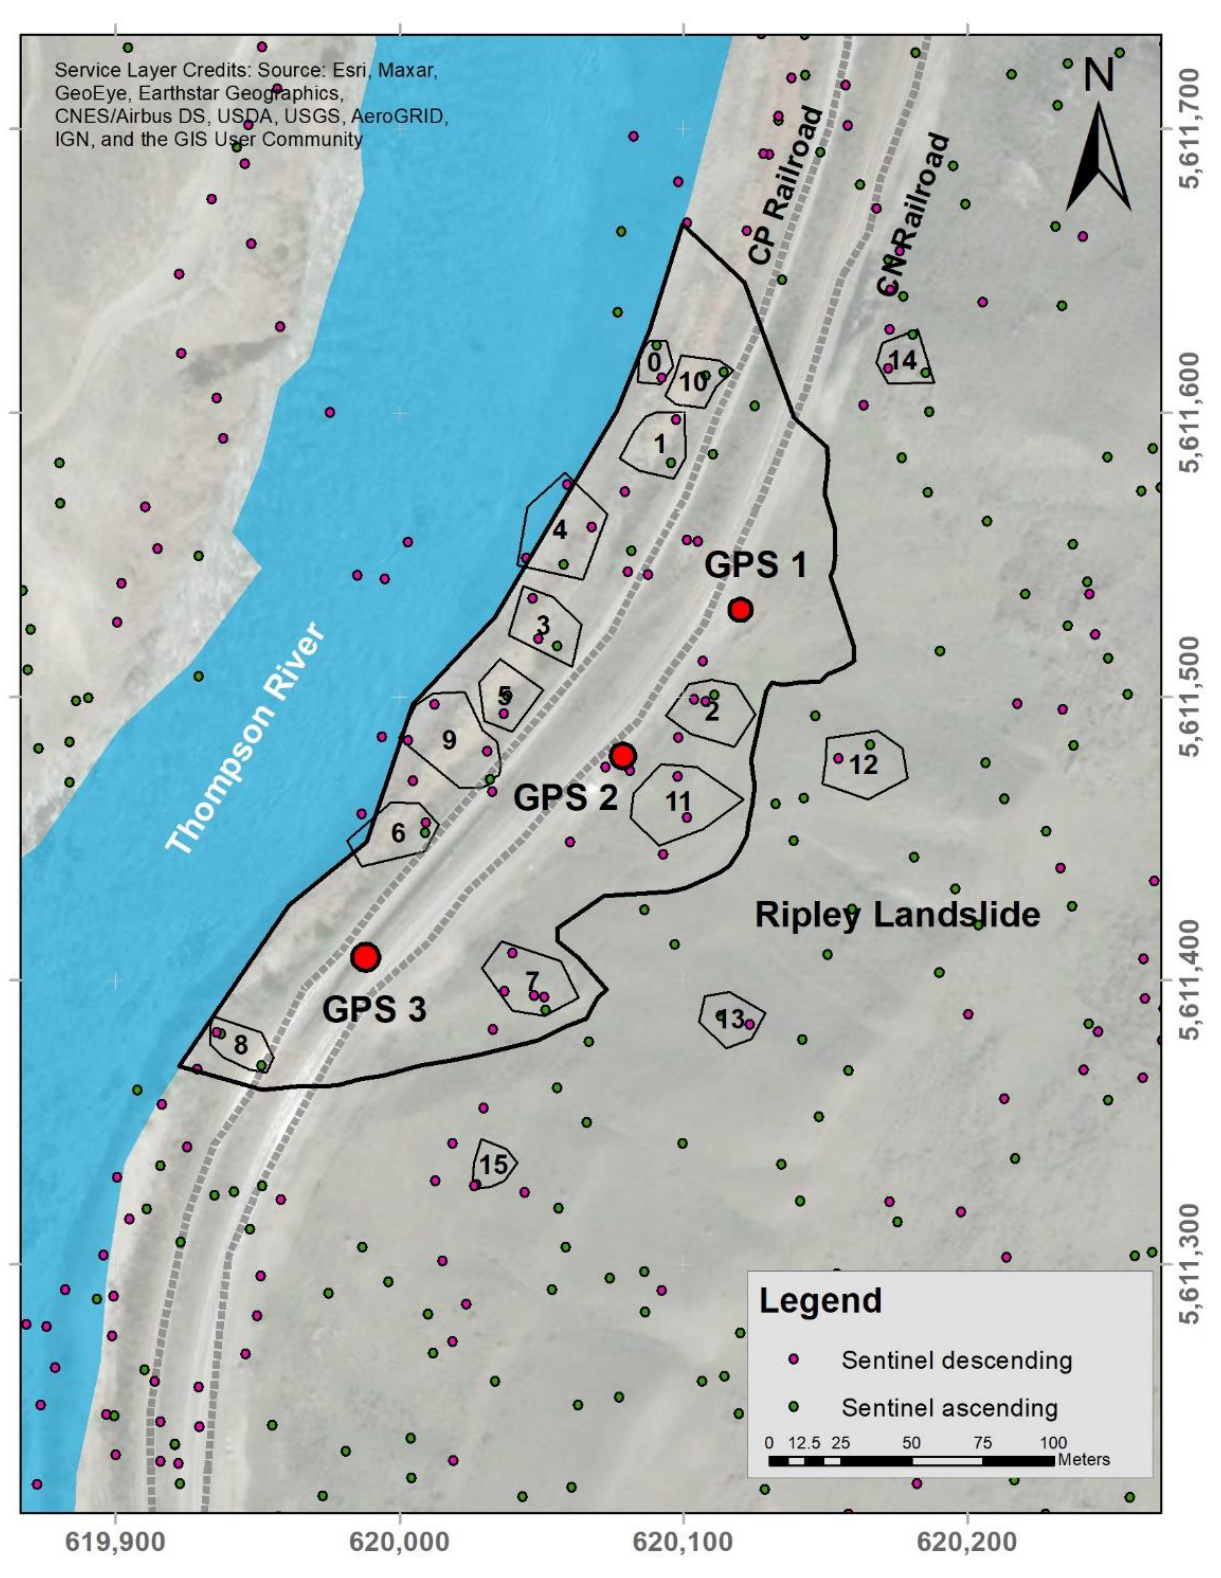
Figure 3. Location of installed GPS systems on Ripley landslide.